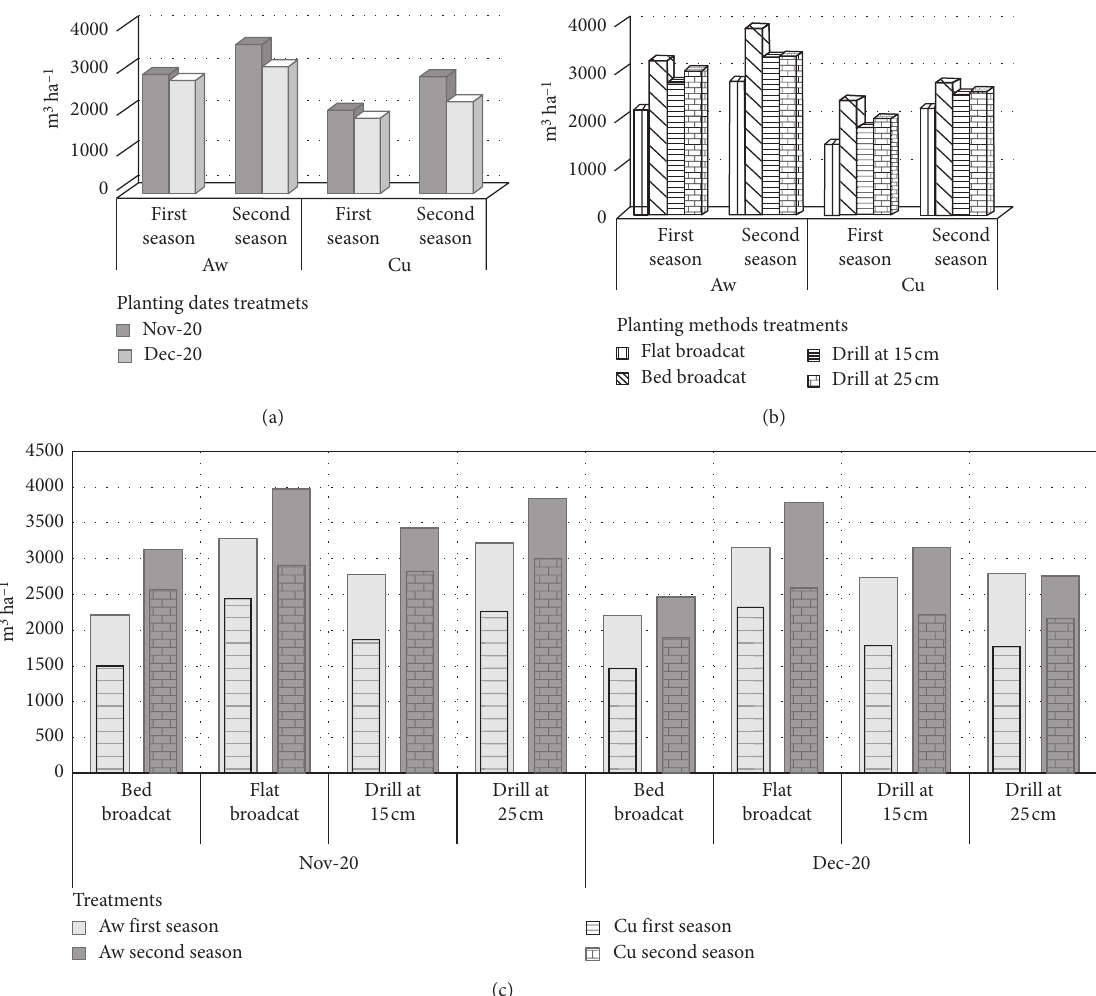
Figure 4: Applied water amounts and actual water consumptive use (m 3 · ha − 1 ) as affected by (a) planting dates, (b) planting methods, and (c) the interaction between them in the two growing